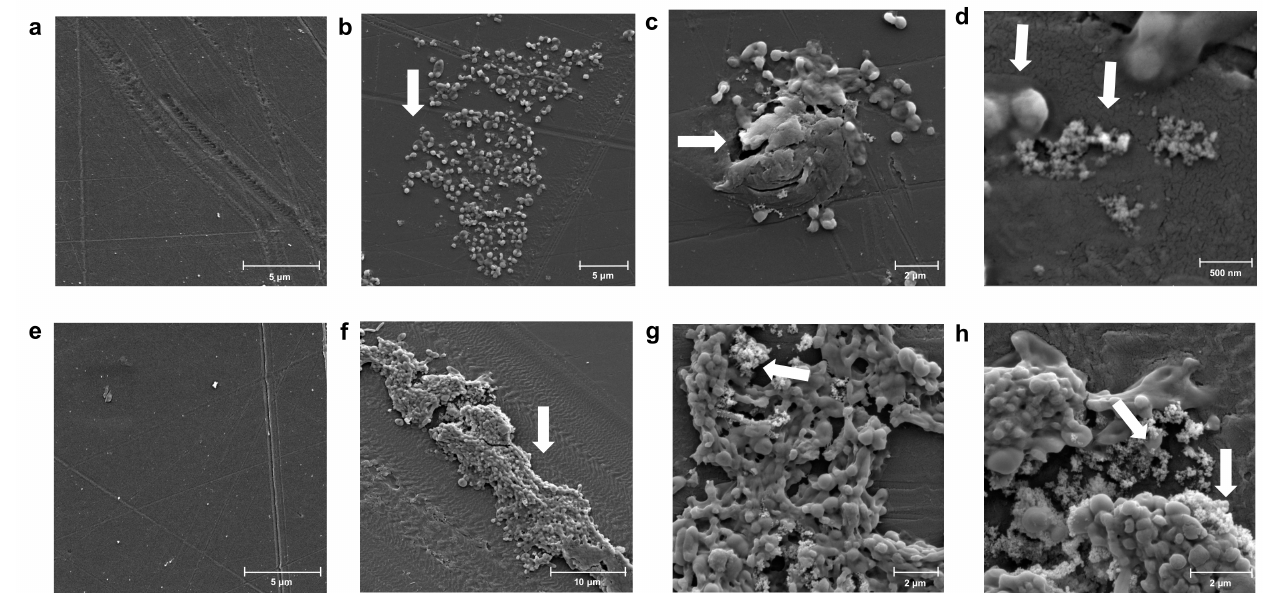
Figure 3. Biofilm formation by Exiguobacterium sp. RIT 594 on PS over 14 days. The pattern of distribution of the particles, both inside the biofilm as well as in contact with the cells, suggests that these particles arise from the active biological degradation of PS; the most interesting features of the SEM images are indicated by white arrows. ( a ) A control PS piece of 0.19 mm thickness at 11,700 × resolution, scale bar 5 µ m; ( b – d ) Exiguobacterium sp. RIT 594 grown in LB with sterilized PS pieces for 7 days. ( b ) 7250 × resolution, scale bar 5 µ m, showing a thin biofilm; ( c ) 16,000 × resolution, scale bar 2 µ m, showing “eruptions” on the polymer surface containing biofilm associated with groups of smaller particles; ( d ) 79,000 × resolution, scale bar 0.5 µ m, showing nanometer-sized particles associated with cells; ( e ) a control PS piece of 0.19 mm thickness at 11,700 × resolution, scale bar 5 µ m. ( f – h ) Exiguobacterium sp. RIT 594 grown in LB with sterilized PS pieces for 14 days. ( f ) 5700 × resolution, scale bar 10 µ m, showing a thicker biofilm; ( g ) 17,200 × resolution, scale bar 2 µ m, showing cells in a biofilm associated with nanometer-sized particles; ( h ) snapshot of ( g ) at 23,400 × resolution, scale bar 2 µ